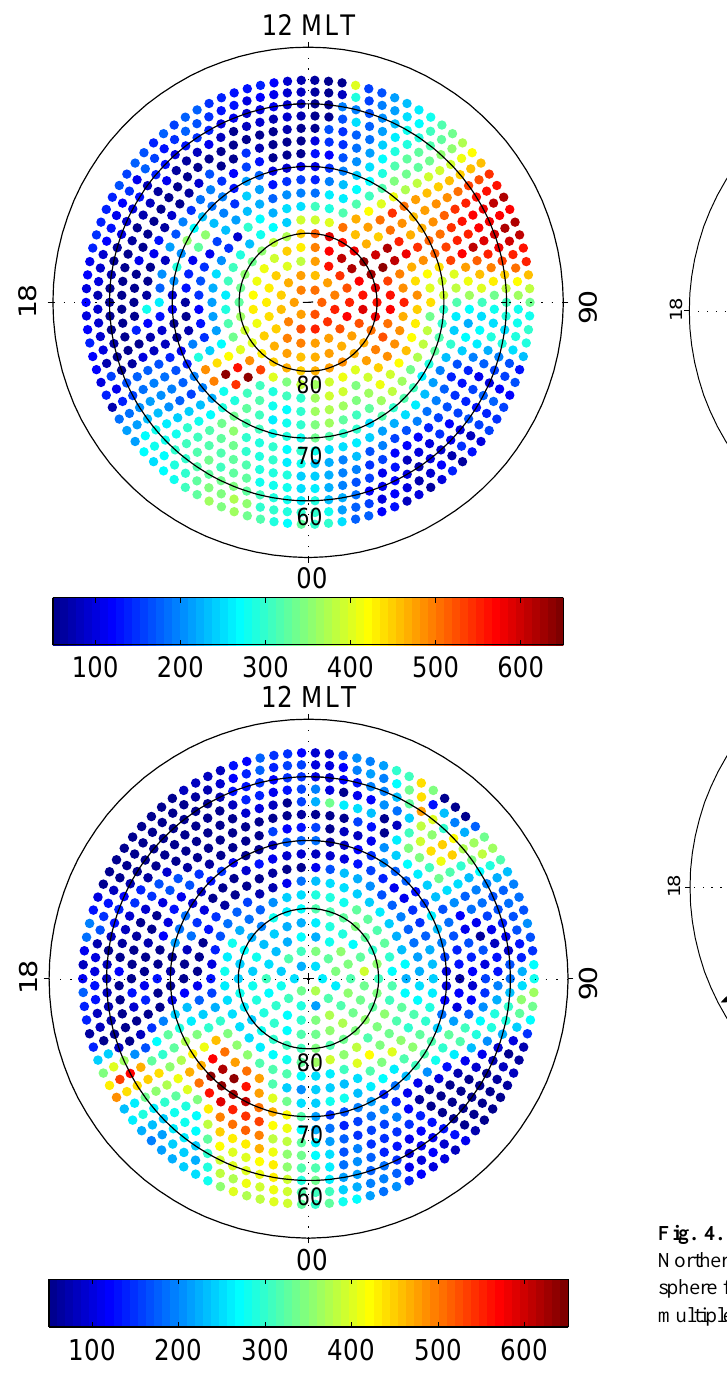
Fig. 3. Distribution of the mean thermospheric wind speed (m/s) in the northern (top) and southern (bottom) polar region around the June 2003 solstice.